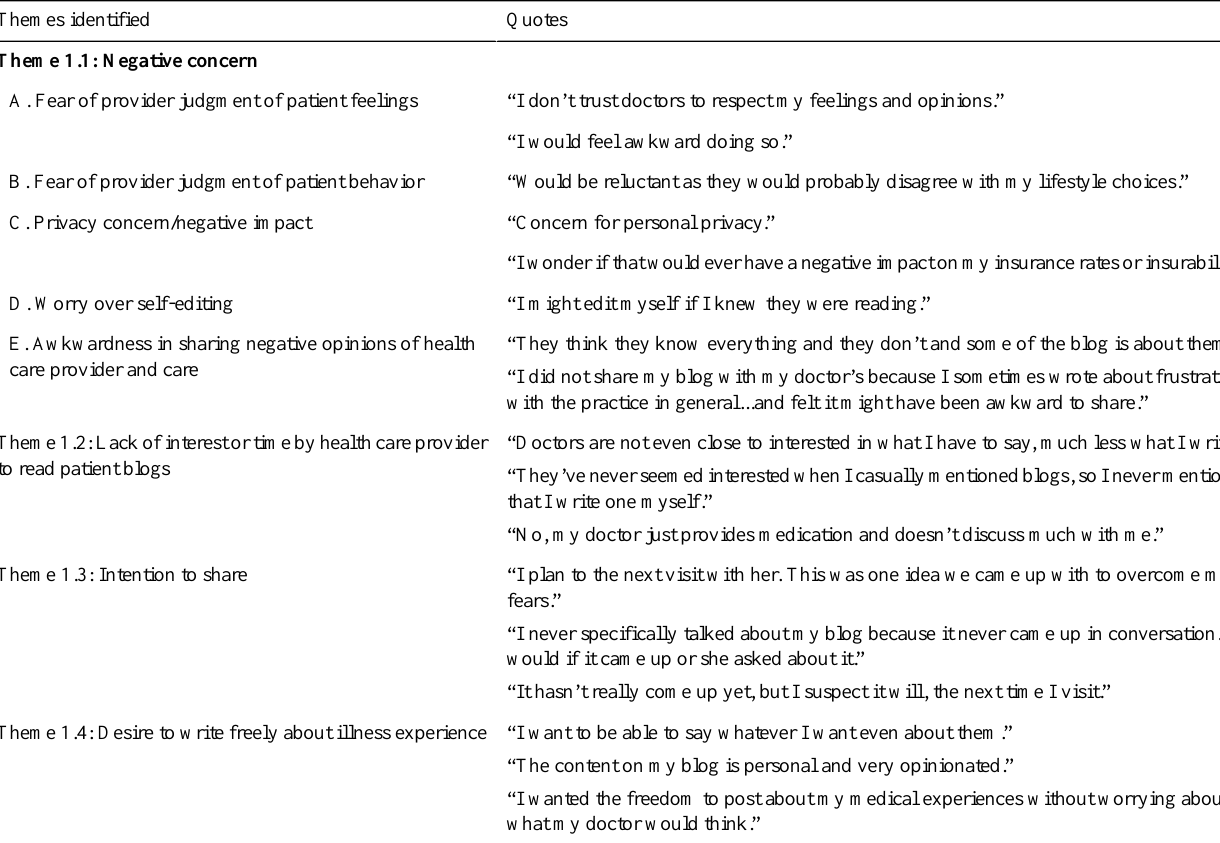
Table 3. Respondents’reasons for not sharing their blogs with their health care